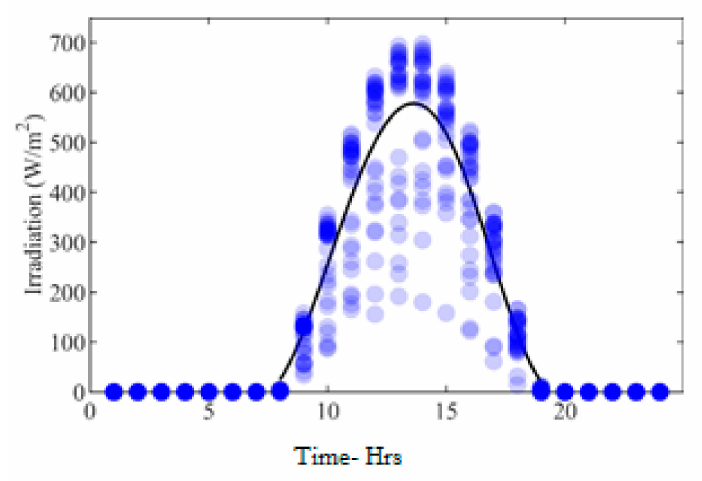
Figure 5. Normal year-round variation in solar irradiation of